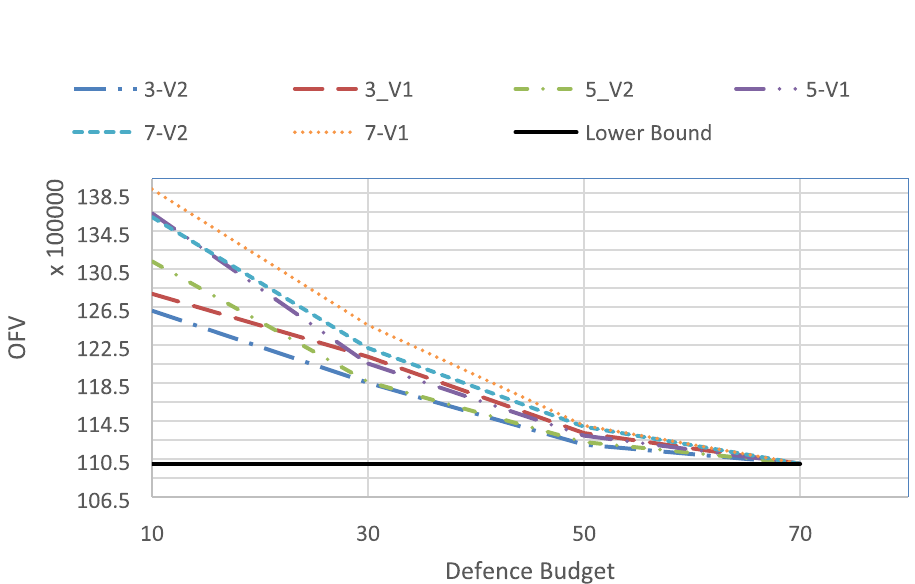
Fig. 7 Performance of Variant 1 and Variant